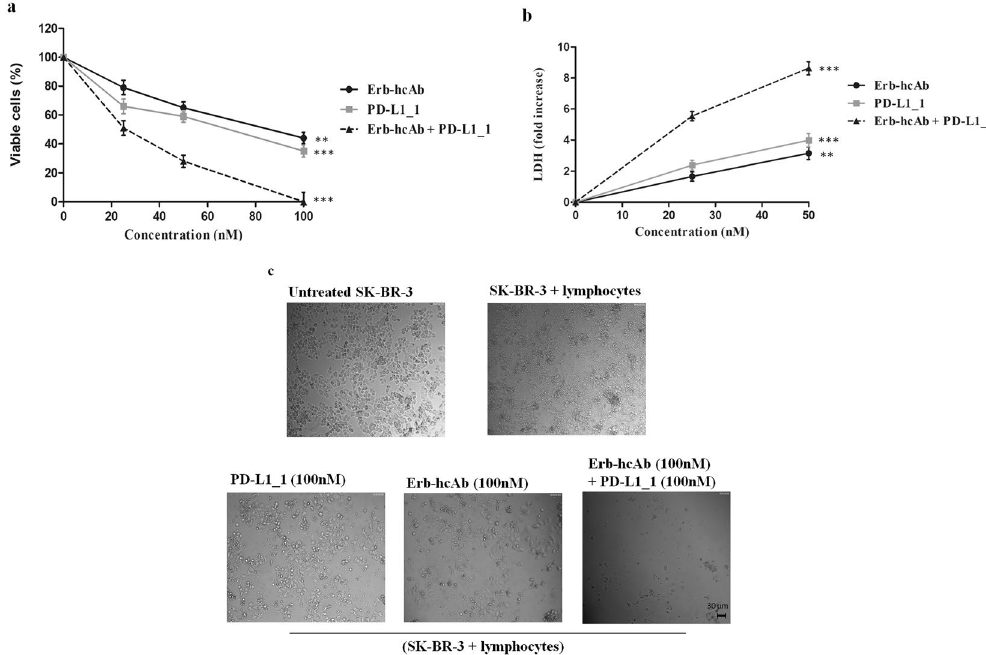
Figure 9. Cytotoxic effects of Erb-hcAb, PD-L1_1 or their combination on tumor cells in the presence of lymphocytes. ( a ) SK-BR-3 cells were co-cultured with lymphocytes (effector: target ratio 10:1), and treated for 24 hours with Erb-hcAb (balck curve, circles) or PD-L1_1 (grey curve, squares) mAbs used alone, or in combination (dashed curve, triangles), at the indicated concentrations. SK-BR-3 cell survival is expressed as percent of viable treated cells with respect to untreated cells. ( b ) SK-BR-3 cell lysis, measured by the LDH release after the incubation with Erb-hcAb or PD-L1_1 mAbs, used alone or in combination at the indicated concentrations. The levels of LDH are expressed as a fold change with respect to the level detected in untreated cells, used as a negative control. ( c ) Images of SK-BR-3 cells treated with each mAb or with the combination of the antibodies tested at the highest concentration (100 nM) in the presence of lymphocytes. The untreated cells in the presence of lymphocytes were used as a negative control. Error bars depicted means ± SD. P values for the indicated mAbs relative to untreated cells, are: *** P ≤ 0.001; ** P < 0.01. Scale bar = 30 μ